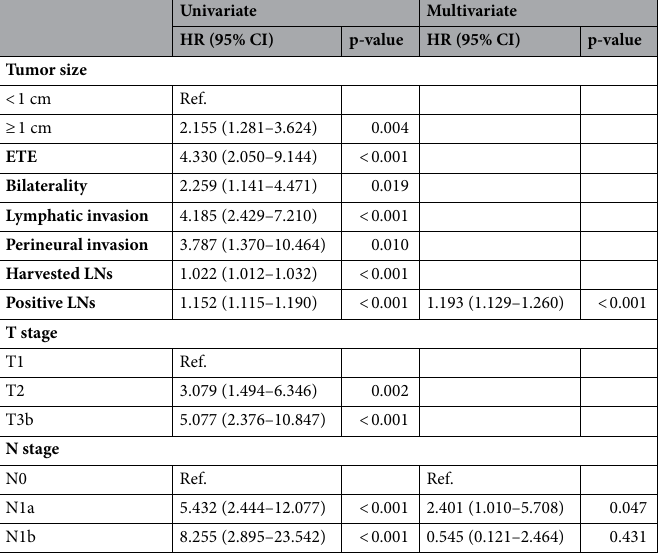
Table 3. Univariate and multivariate analyses of risk factors for recurrence after propensity score matching. Data are expressed as hazard ratio (HR) and 95% confidence interval (CI). A p value < 0.05 was considered statistically significant. ETE extrathyroidal extension, LN lymph node, T tumor, N node.